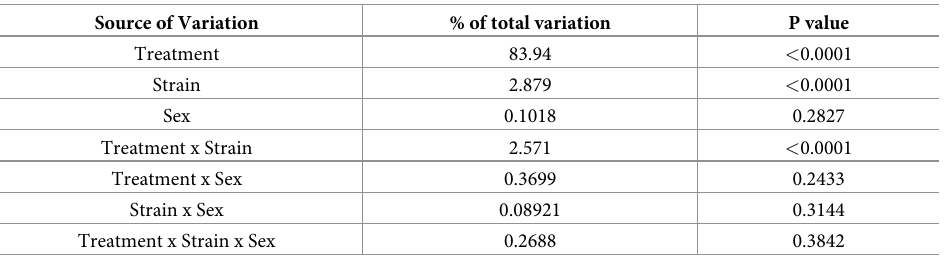
Table 1. Three-way ANOVA analysis of percent change in body weight. Source of Variation % of total variation P value Treatment 83.94 Strain 2.879